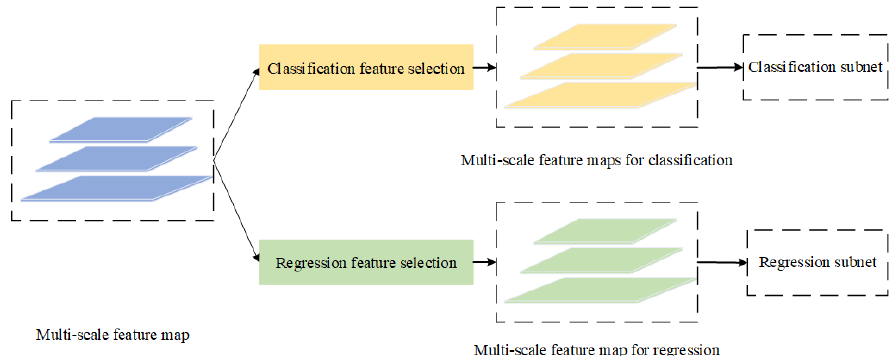
Figure 4. Multi-feature selection of multi-scale feature